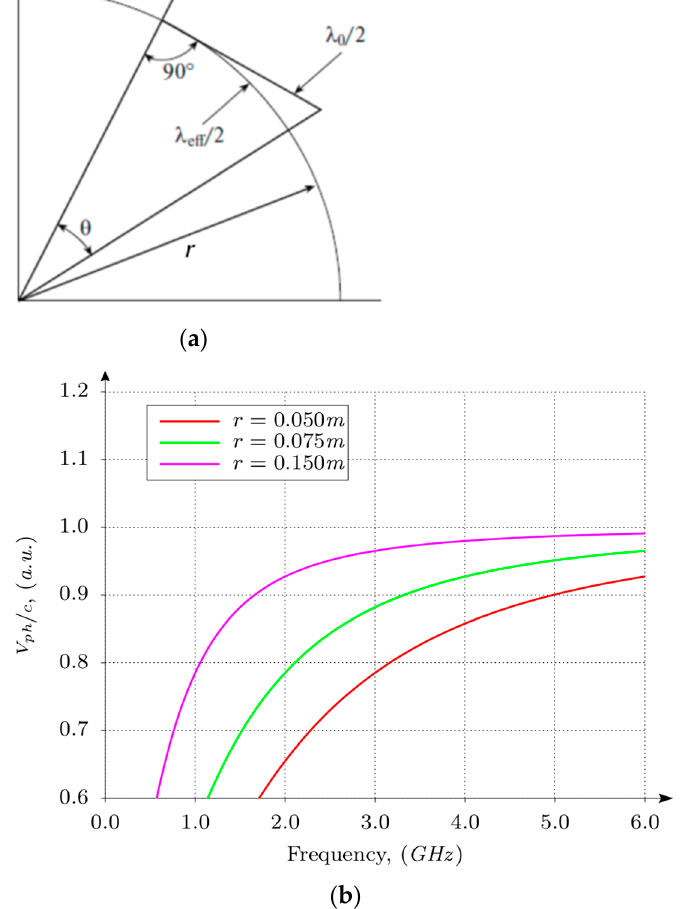
Figure 17. ( a ) Simplified geometry of a shoulder for creeping wave phase velocity modeling; ( b ) Analytical frequency dependence of the normalized phase velocity.